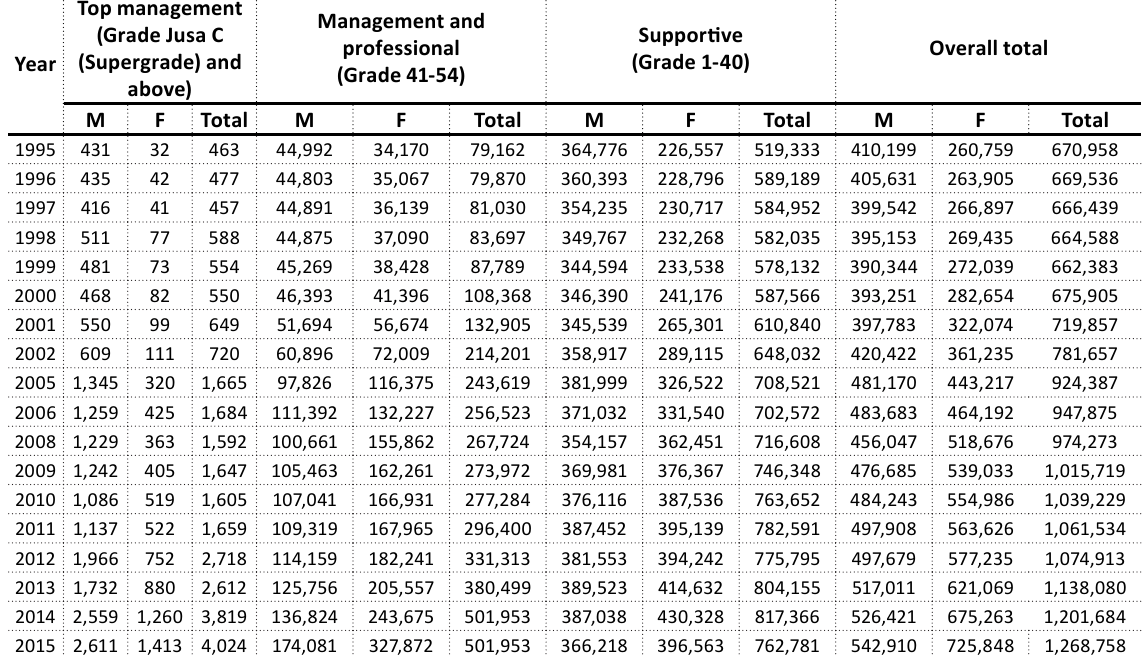
Source: Ministry of Human Resource